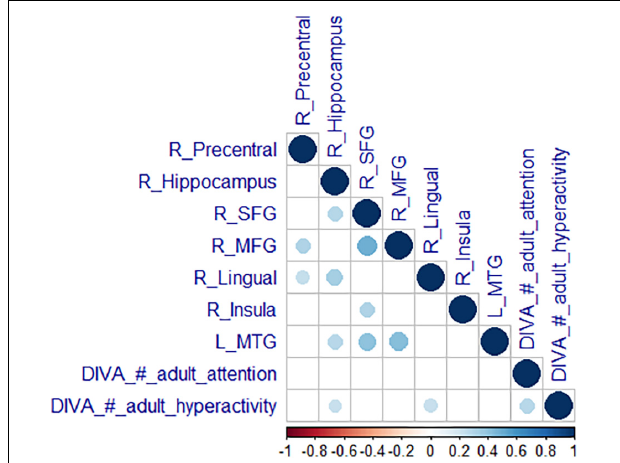
FIGURE 4 | Correlation of neural activity with symptoms. Correlation matrix of mean estimates in the significant clusters from the reactive aggression whole-brain analysis with expressions of the core symptoms (attention and hyperactivity). We are reporting Spearman’s correlation coefficient p (bottom scale) with a blue color for a positive and a red color for a negative correlation. Results were Bonferroni corrected.